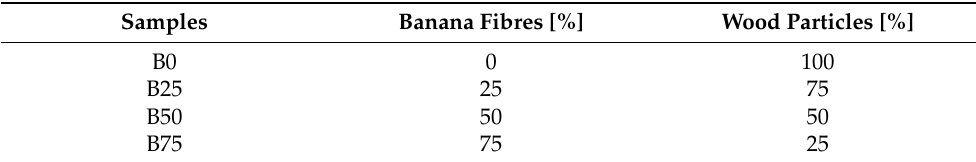
Table 1. Mix percentages of the boards (by weight).